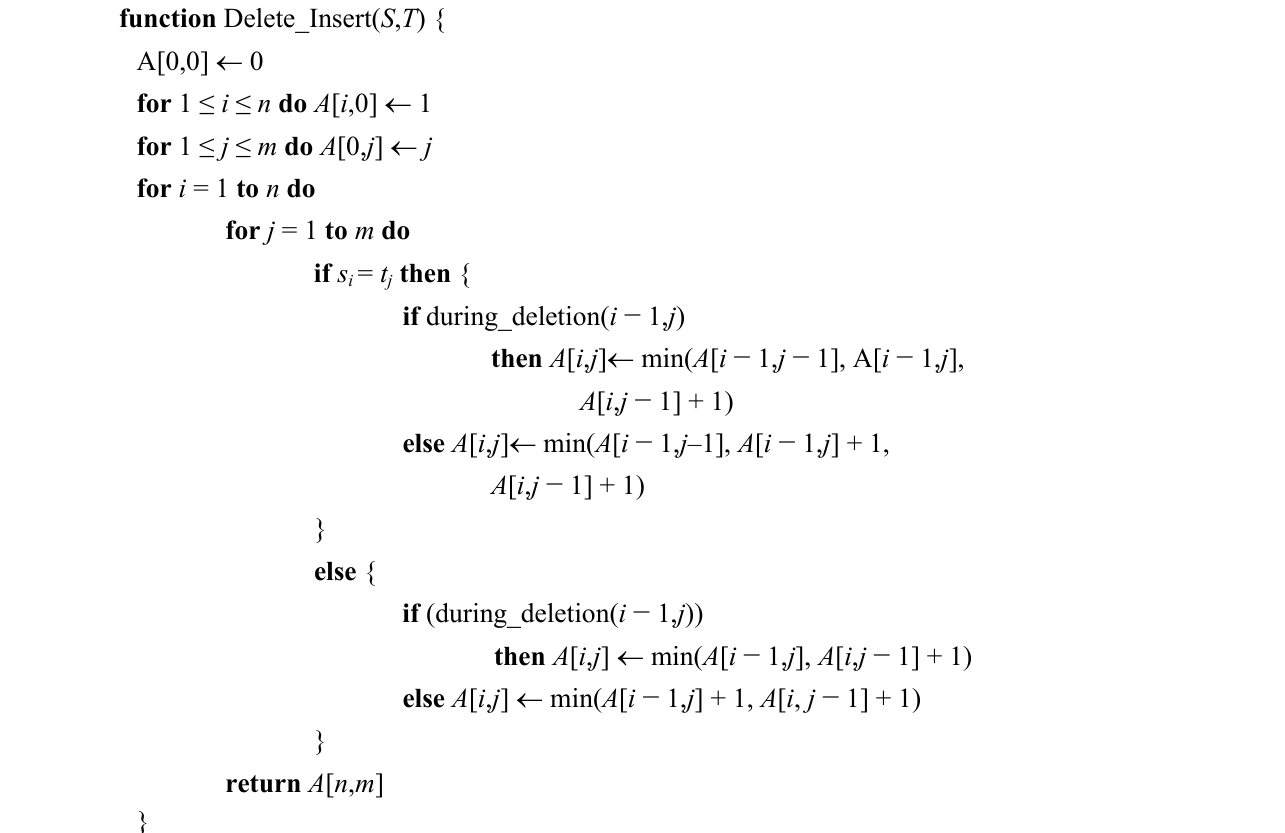
Algorithm 3. Edit Distance with Block Deletions and Character